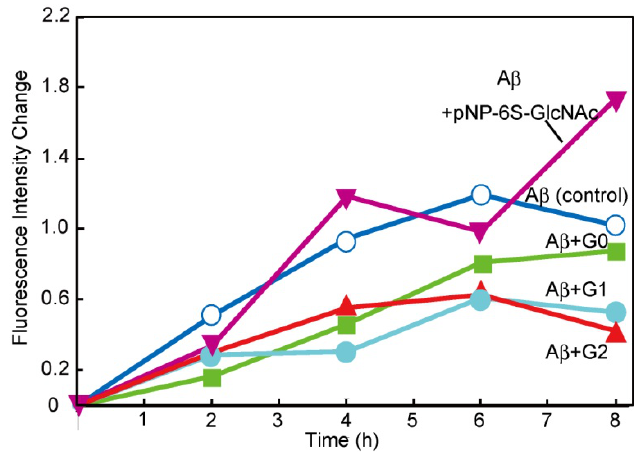
Figure 4. Time course of the fluorescence change in ThT with A β (1-42) (20 μ M) and sugar derivatives (200 μ M) in the phosphate